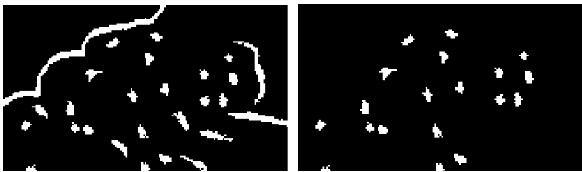
Figure 10: Example showing regional maxima (left) and the detected grape berries after filtering with respect to eccentricity